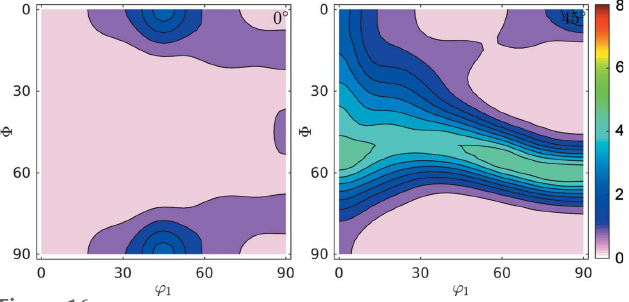
Figure 16 ODF for the 5 s, 730 (cid:6) C heat-treated sample. ’ 2 = 0 (cid:6) and ’ 2 = 45 (cid:6) .